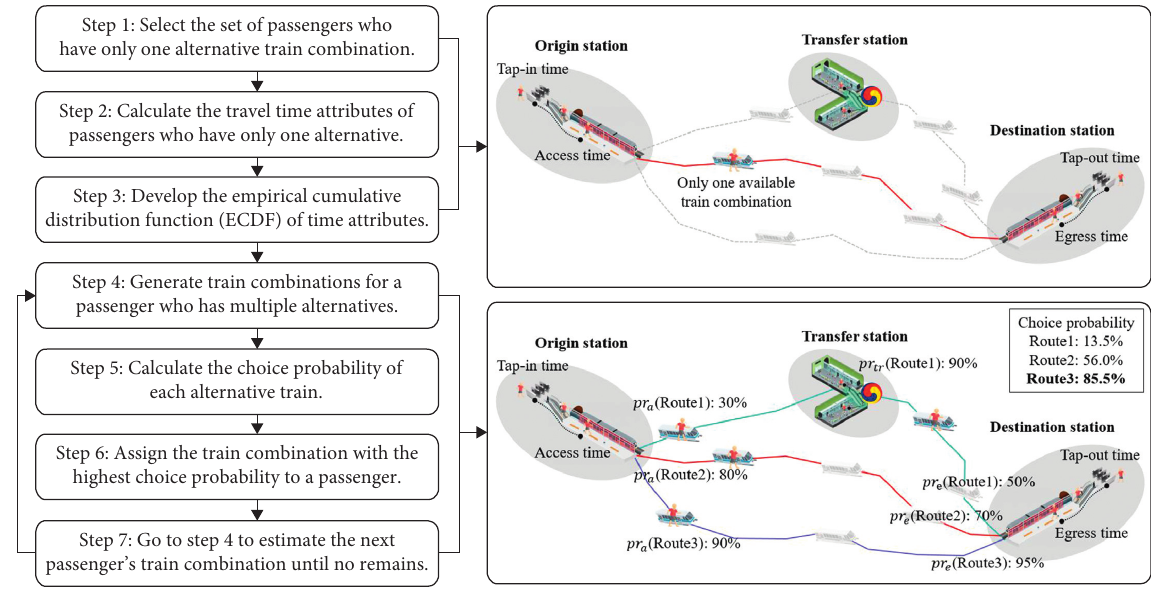
Figure 2: Visualized concept of train choice